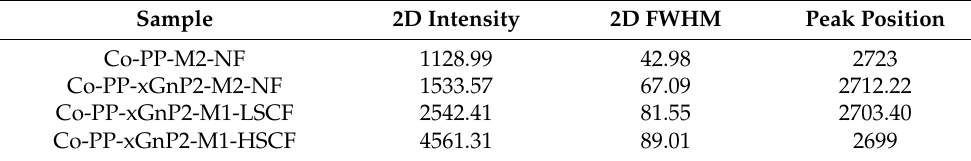
Table 7. The data extracted from the Raman spectrum of Figure 10. Raman spectrum of nanocomposite with 1 wt % xGnP prepared by Method 1. xGnP: graphene nanoplatelet.